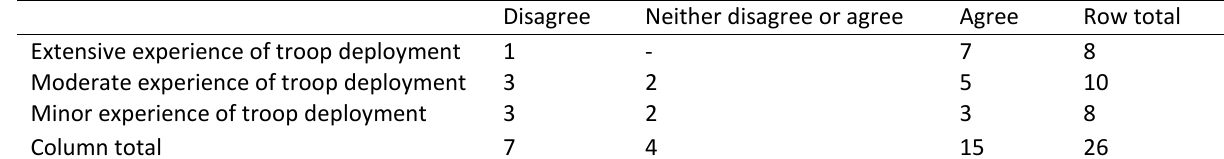
Table 3. Experience of international deployment related to the proposition “Social media use in an area of deployment place soldiers at risk by revealing sensitive